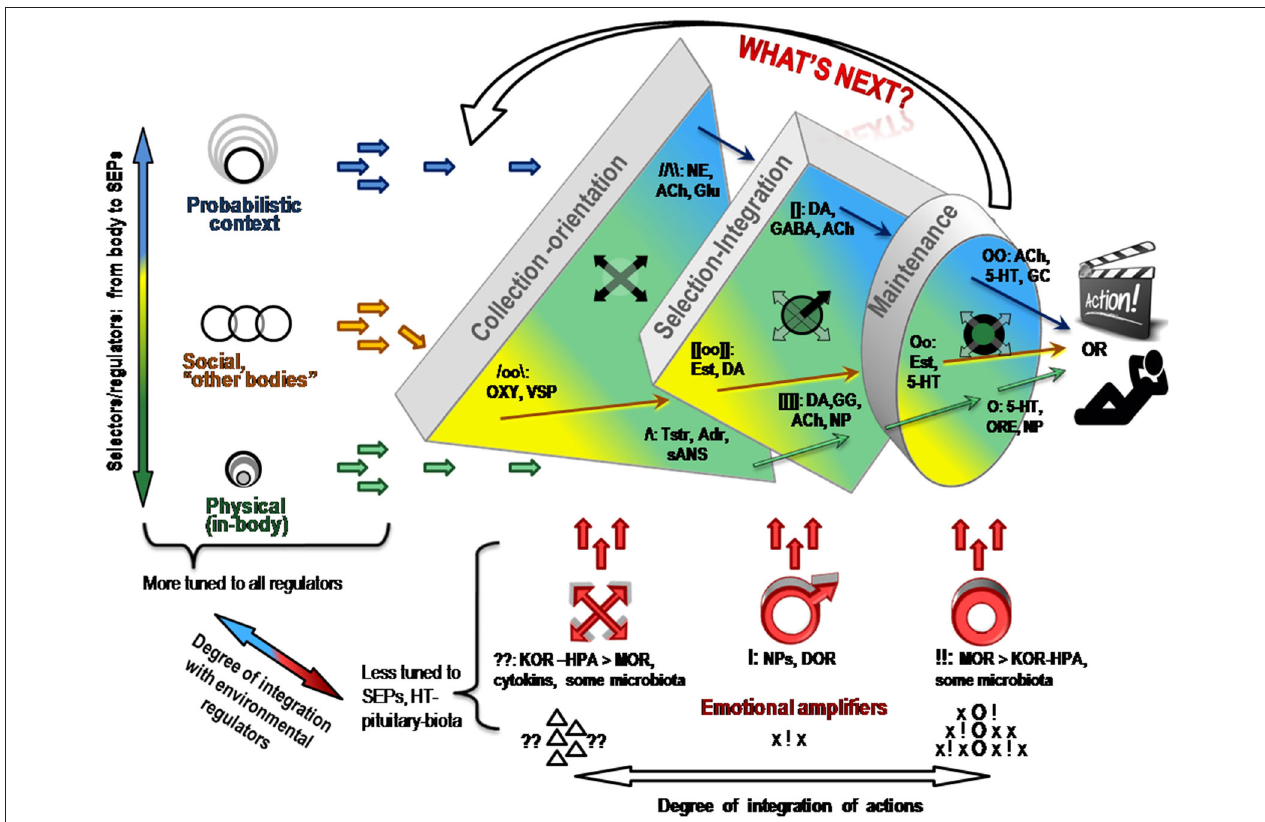
FIGURE 3 | Neurochemical model Functional Ensemble of Temperament is presented here as a progression in the selection of behavioral alternatives in three approximate stages. There is an interaction between neurochemical teams within and across these stages. Emotional amplifiers coincide with the functionality of each stage. Ach, acetylcholine; NE, noradrenaline; 5-HT, serotonin; DA, dopamine; OXY, oxytocin, VSP, vasopressin, Tstr, testosterone; Adr, adrenalin; GC, glucocorticoids; ORE, orexins; NP, neuropeptides; Glu, glutamate; GG, GABA and Glu; OR, opioid receptor